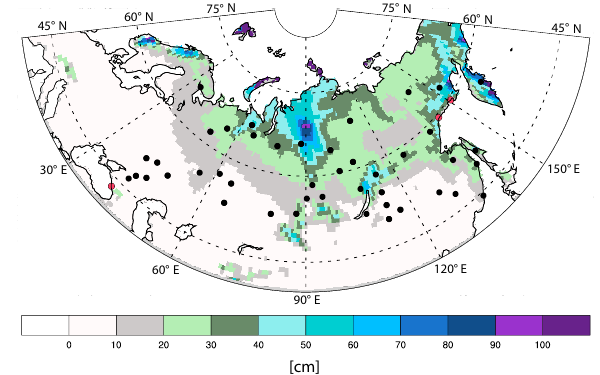
Figure 1. Station location and snow depth (cm) for the 2000–2013 MAMJ average taken from ERAI-L. Red-coloured stations are ex- cluded by the land–sea mask of